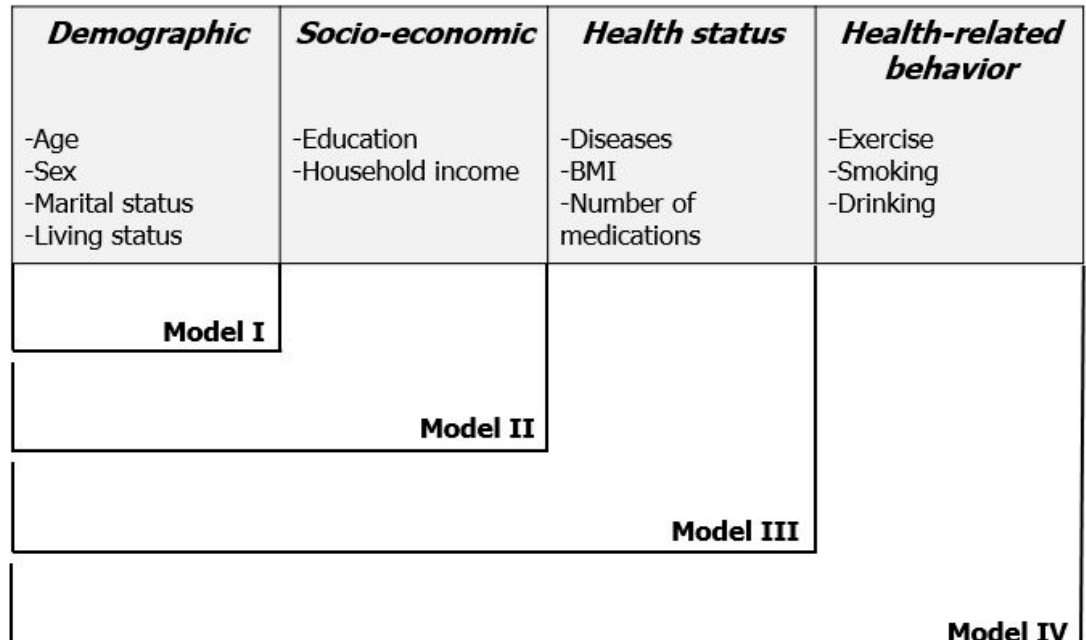
Figure 2. Suggested individual variable-adjusted models. The demographic, socio-economic, health status, and health-related behavior variables were combined in groups, and four models were established.